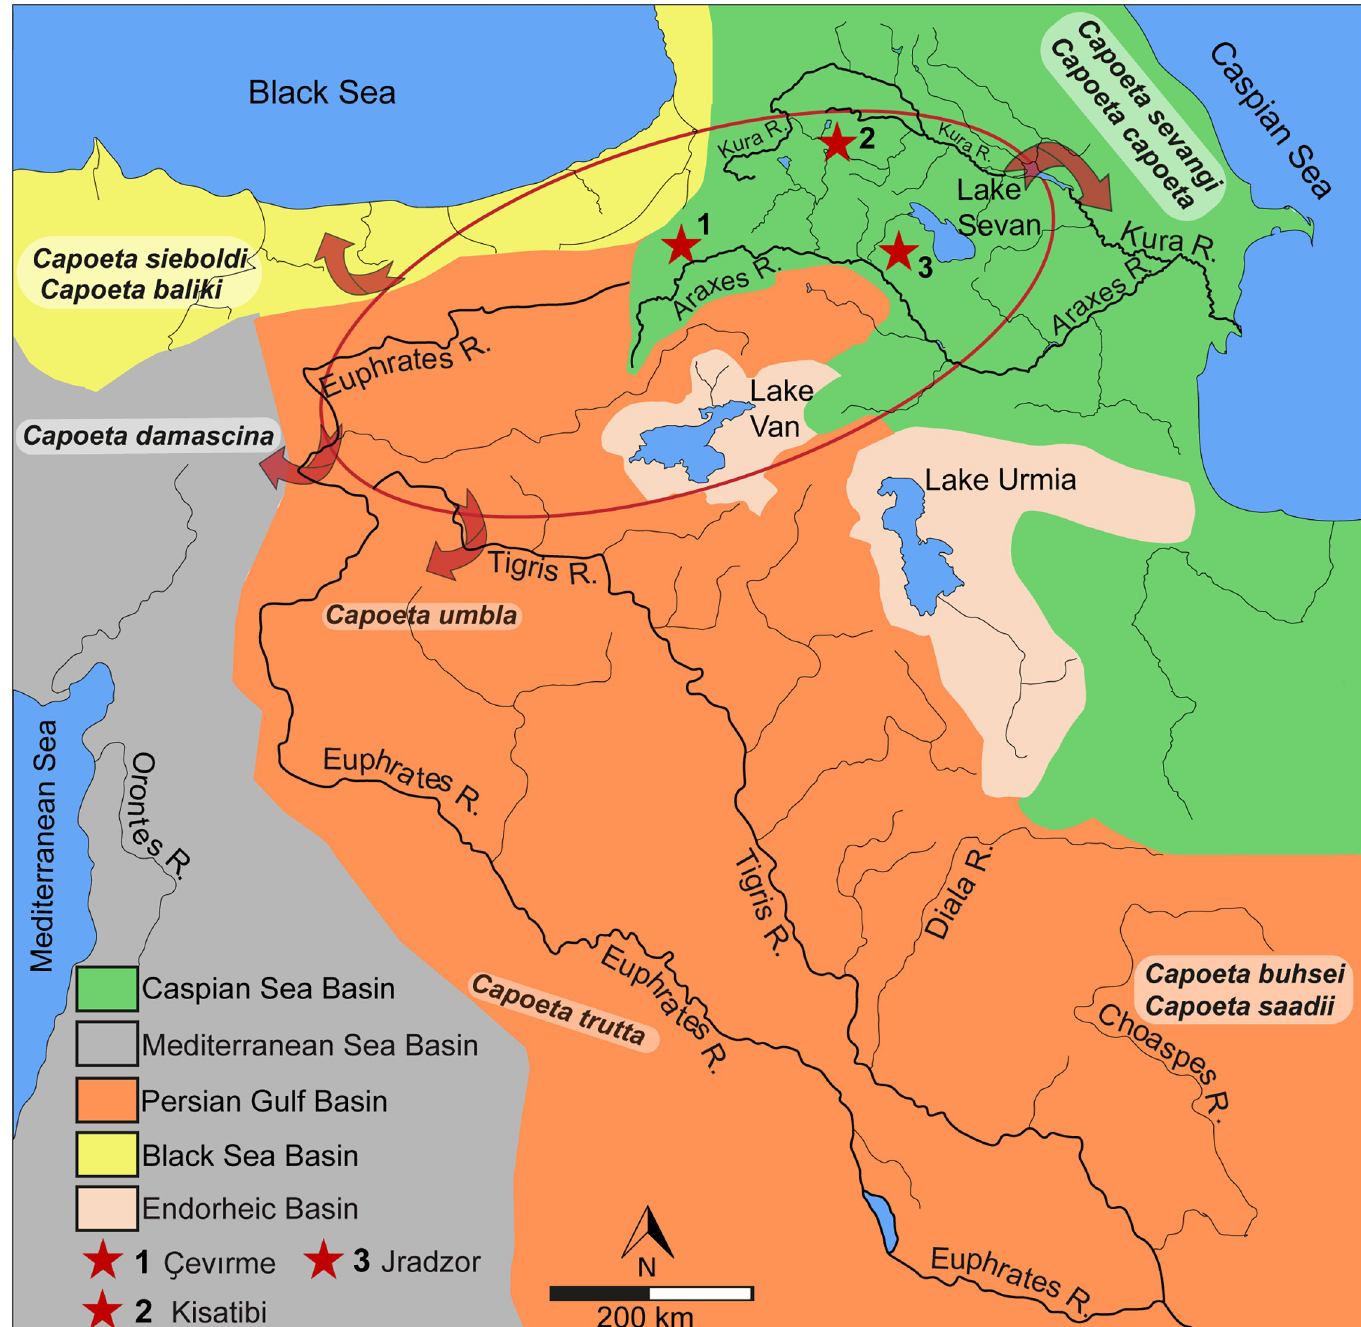
Fig 2. Geographical overview of the drainage systems of Western Asia and the Ponto-Caspian regions (Euphrates-Tigris, Araxes-Kura). Red star (1) indicates the position of the C¸evırme locality. The red circle shows the possible extension of palaeolake system of the Armenian Highland. The arrows show the late distribution of the recorded fossil Capoeta species into the different water basins due to the tectonic disruption of the Lake system during the Pliocene uplift period. The two already known late Miocene fossil sites Kisatibi (red star 2) and Jradzor (red star 3) are included as well. Map data: Fig 2 is redrawn and modified from U. S. Geological Survey CC BY 4.0.